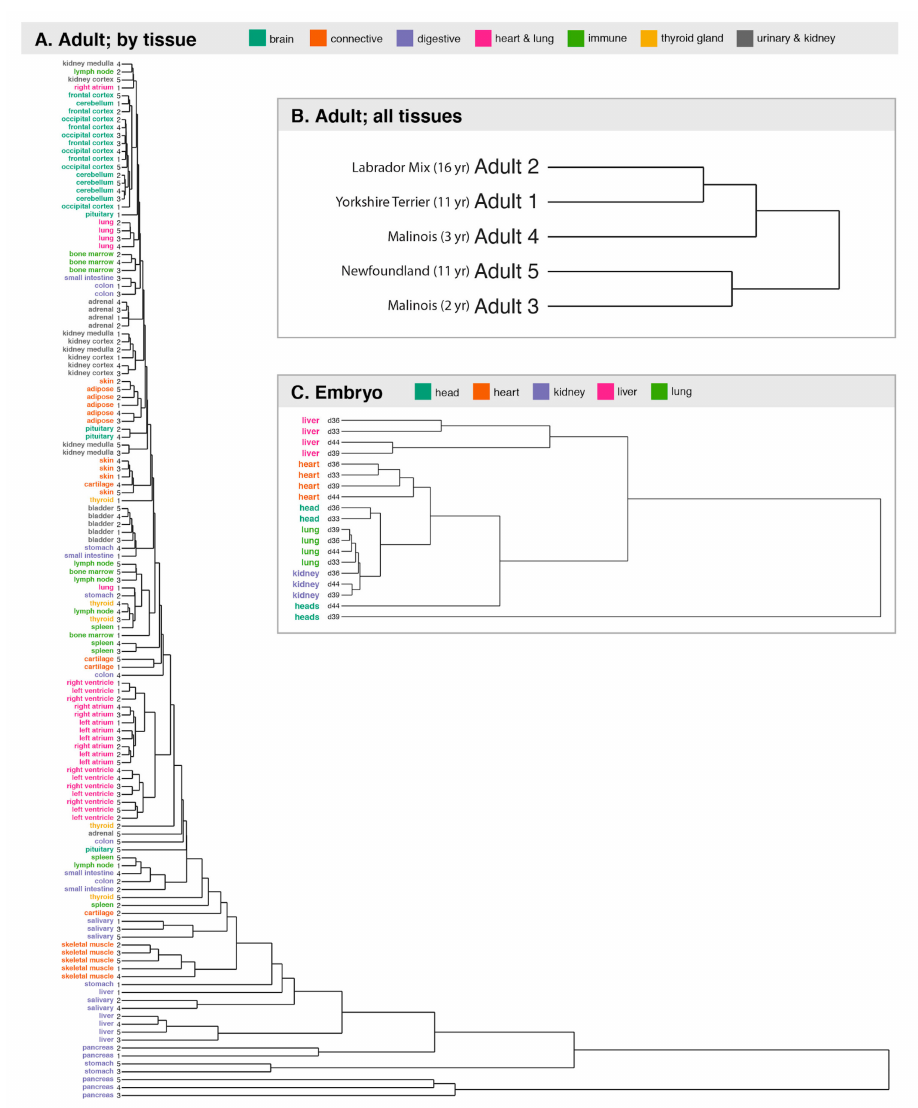
Figure 5. Transcriptome data from five individuals clusters primarily by tissue type. Hierarchical clustering of RNA-seq data from ( A ) single tissues of five adult dogs; ( B ) five adult dogs, based on data concatenated across 21 tissues; and ( C ) embryonic tissues sampled at four gestational time points. Clustering is based on Euclidean distances among samples. Overall, in data from both adults and embryos, samples of a given tissue cluster across individuals. As observed in cumulative analysis, embryonic samples of a given tissue type cluster despite variation in gestational time points, perhaps reflecting the fairly narrow time window of